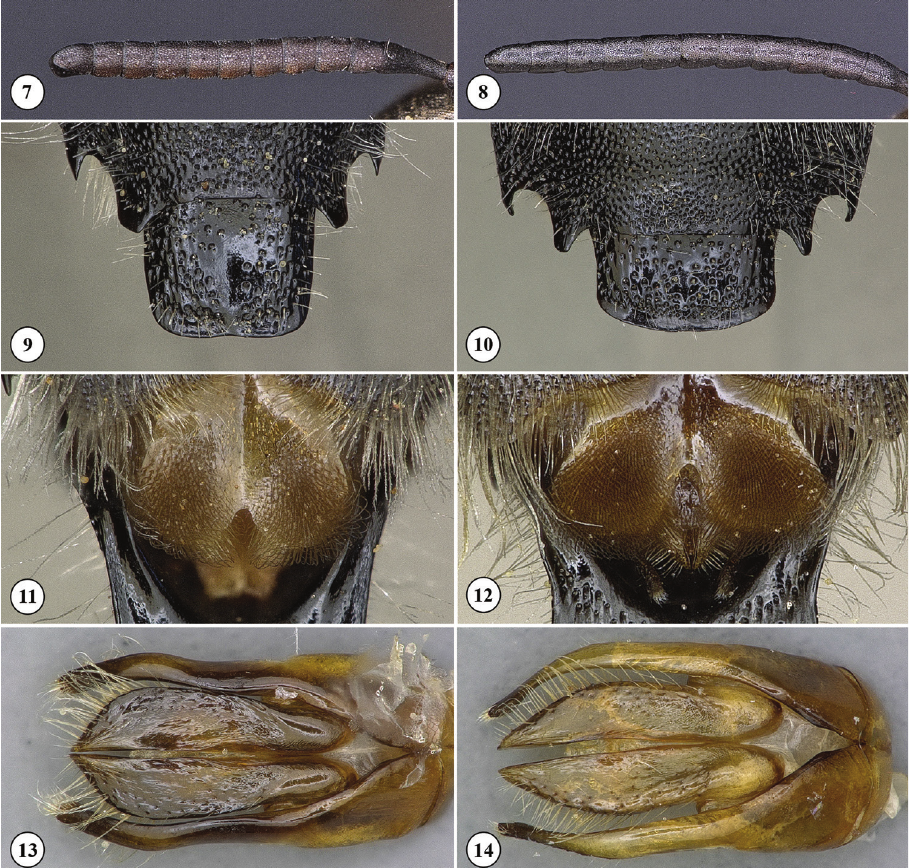
Figures 7–14. Morphological differences in the male sex between Hoplitis mucida (left) and H.